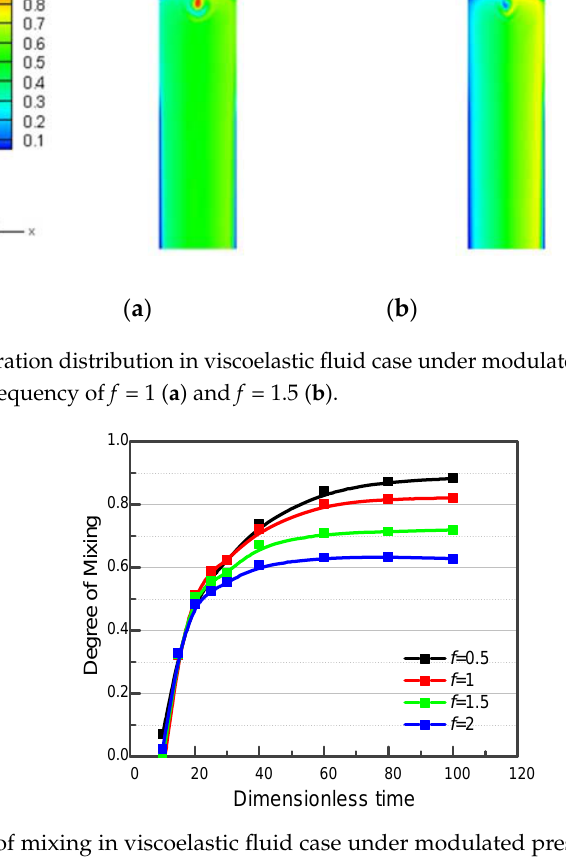
Figure 12. Degree of mixing in viscoelastic fluid case under modulated pressure at both inlets with different amplitudes.